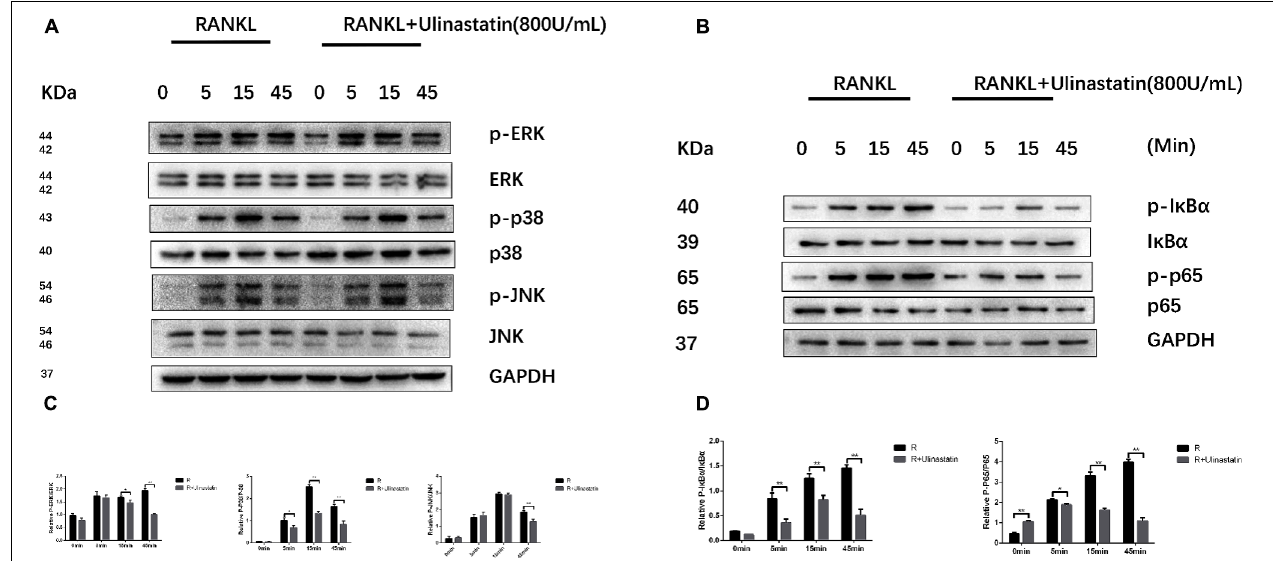
FIGURE 8 | Ulinastatin suppressed RANKL-induced activation of MAPKs and NF- κ B. (A,C) Ulinastatin represses RANKL-induced phosphorylation of ERK, p38, and JNK. BMMs were starved with α -MEM basic medium free from FBS for 12 h, and pretreated with or without ulinastatin (800 units/mL) for 1 h. Then BMMs were treated with or without RANKL (100 ng/mL) and Ulinastatin (800 units/mL) for the indicated times. The total proteins were extracted and examined by western blotting. (B,D) Ulinstatin represses RANKL-induced phosphorylation of I κ B α and p-65. BMMs were treated as described above, and the total proteins were extracted and examined by western blotting. The experiment was performed three times independently and the total protein was used as a loading control. ∗ P < 0.05 and ∗∗ P < 0.01 versus RANKL